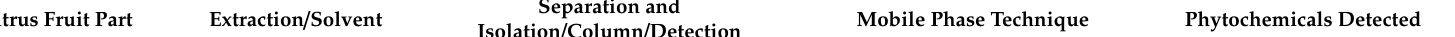
Phytochemicals Detected